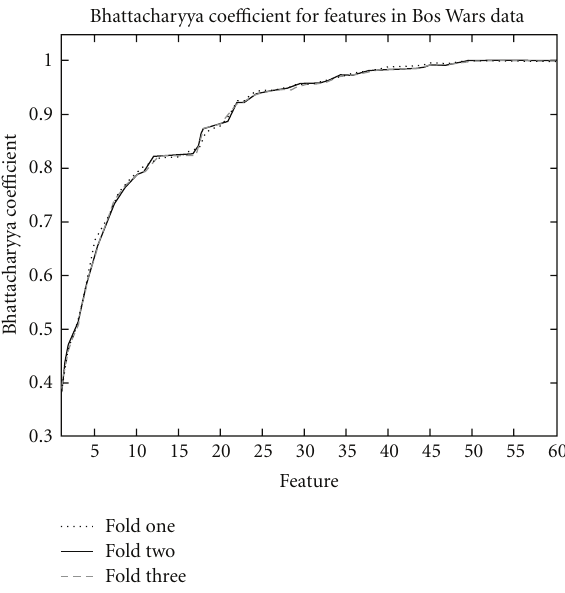
Figure 8: The BC for the features in the Bos Wars training